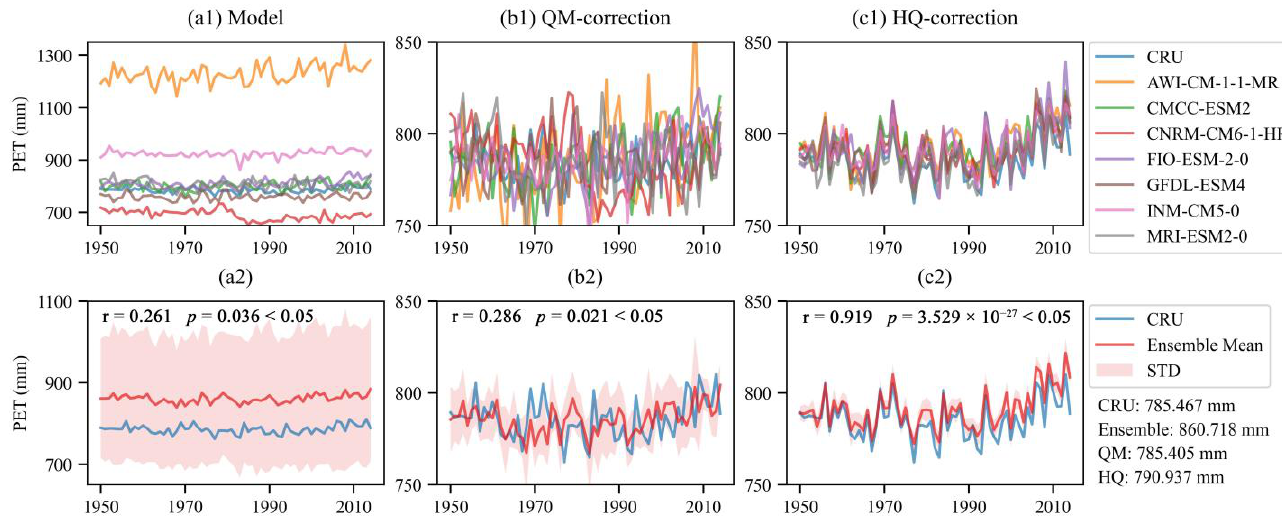
Figure 5. The curve of annual PET over time in the historical scenarios. ( a1 , a2 ) are the comparison of the single model and the ensemble model with CRU data, respectively. ( a – c ) are the comparisons of the original, the QM-corrected, and the HQ-corrected PET, respectively (r is the Pearson correlation coefficient).